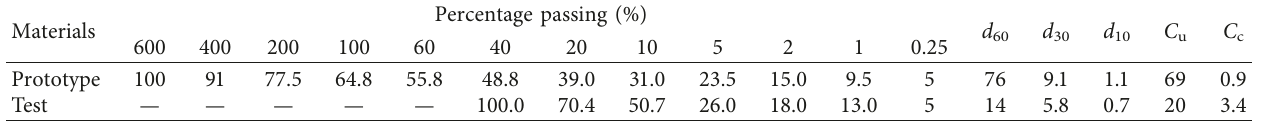
Table 1: Grain-size distribution data of test material.